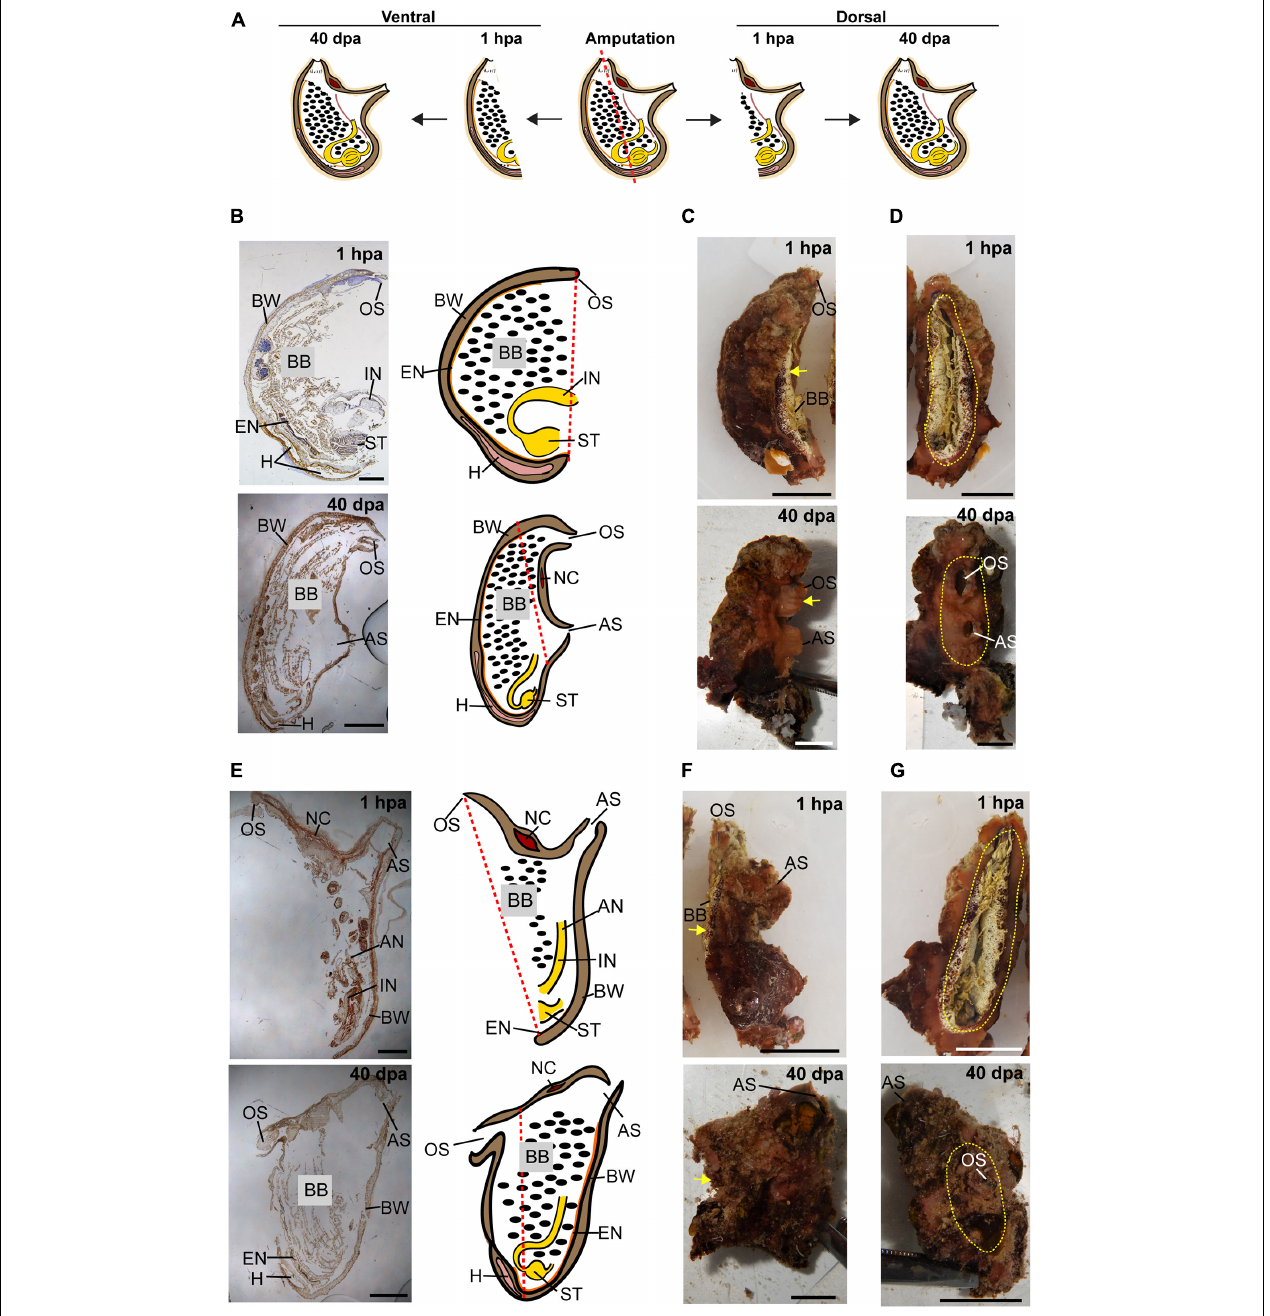
FIGURE 4 | Regeneration along the DV axis of both body fragments is complete by 40 dpa. (A) Illustration depicting regeneration along the DV axis at 1 hpa and 40 dpa. (B–D ) Ventral body part. (B) Sections left view and matching drawing. Red dashed lines indicate amputation line. (C) In vivo images, left view. Yellow arrow indicates wound area. (D) In vivo images, posterior view. Yellow dashed lines indicate wound border. (E–G) Dorsal body part. (E) Sections left view and matching drawing. (F) In vivo images, left view. (G) In vivo images, posterior view. Anus (AN), atrial siphon (AS), body wall (BW), branchial basket (BB), endostyle (EN), heart (H), intestine (IN), neural complex (NC), oral siphon (OS), stomach (ST). Scale bar in (C,D,F,G) : 0.5 cm, and in: (B,E) : 3 mm (see also Supplementary Table 3 and Supplementary Figure 3